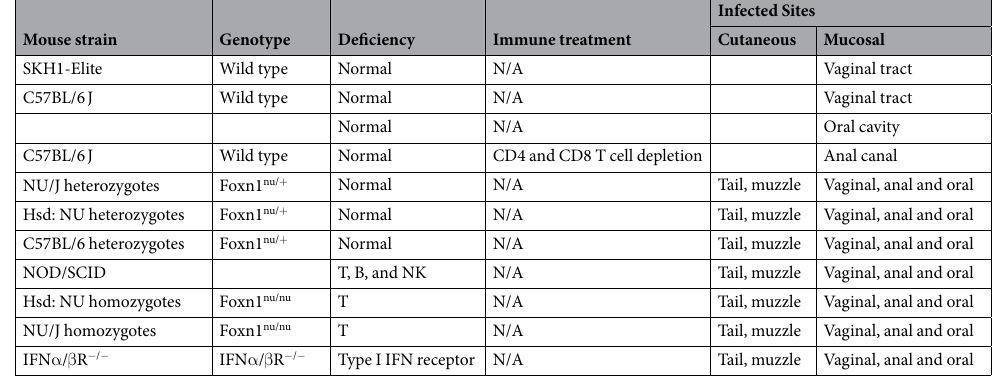
Table 1. The mouse strains used in the current